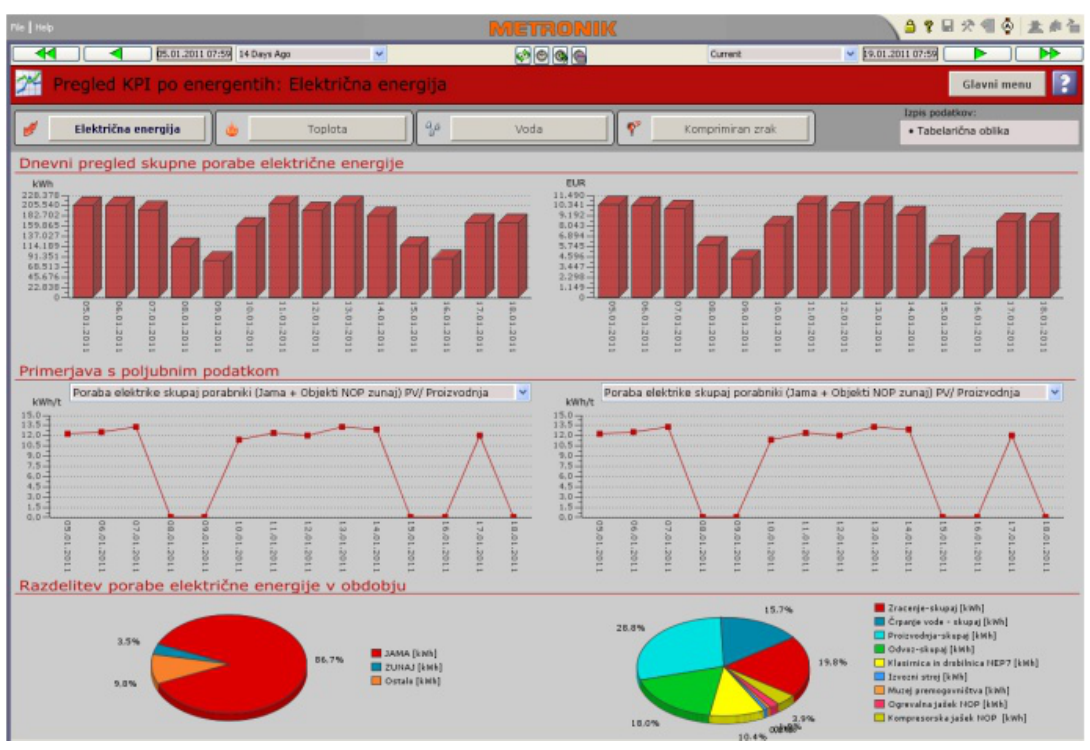
Figure 5. Graphical energy consumption interface in